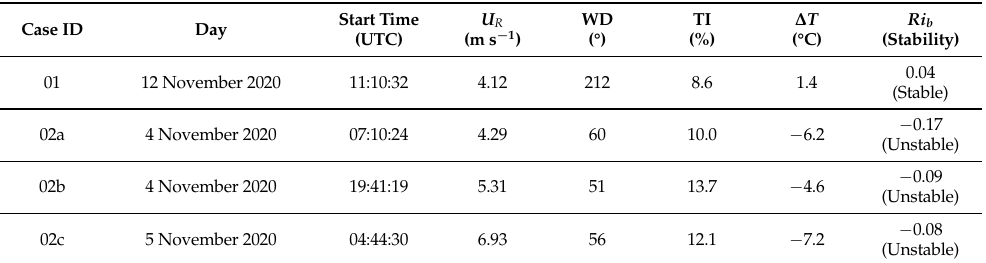
Table 2. Summary of the wind parameters for each test case. Date and time; f-LOS total average radial wind speed (RWS) U R , wind direction (WD), turbulence intensity (TI), air–sea temperature difference ∆ T , and the bulk Richardson number Ri b .